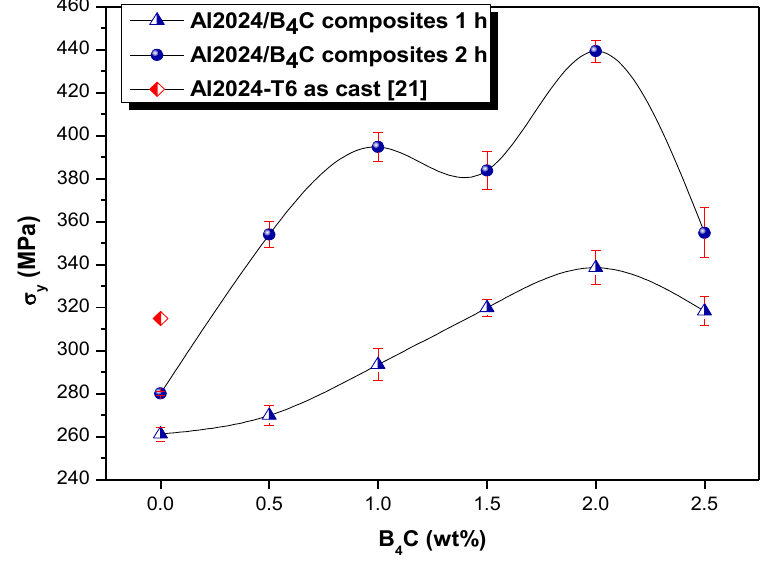
Figure 7. Yield strength ( σ y ) as a function of the B 4 C content and milling time.